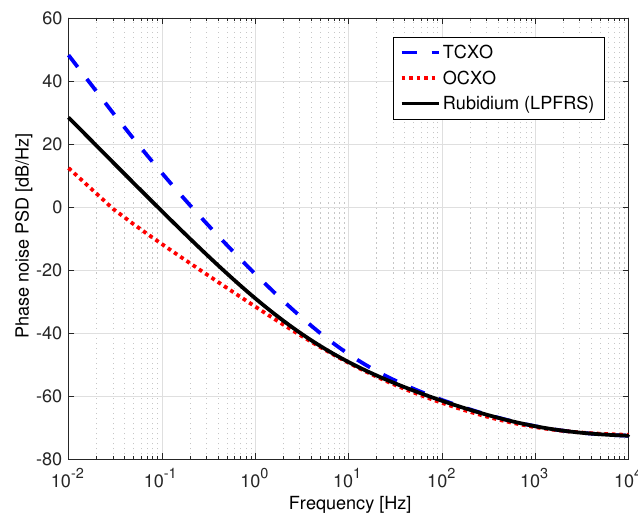
Figure 3. Receiver clock power spectral density (PSD)